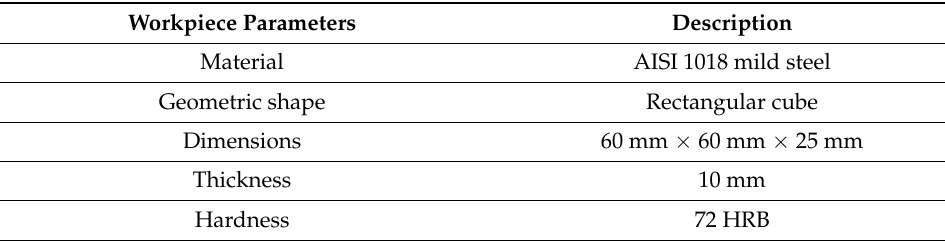
Table 4. AISI 1018 workpiece parameters.